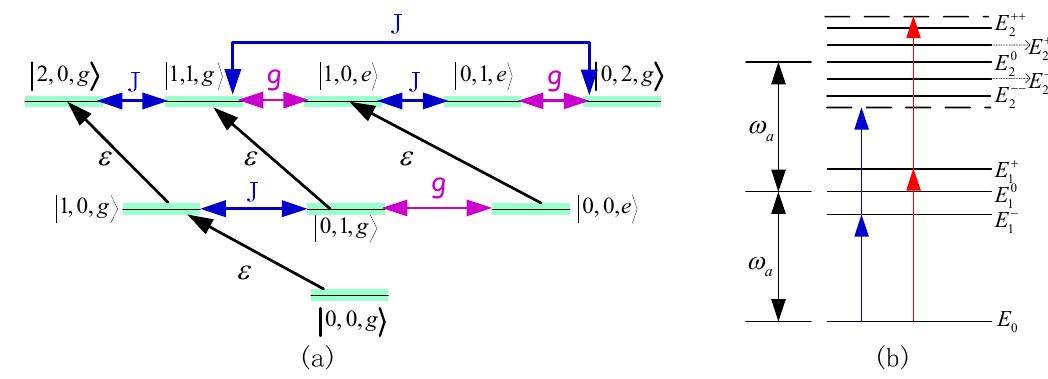
Figure 2. ( a ) Energy levels within two excitation subspaces and the corresponding excitation paths; ( b ) the eigenenergy spectrum of the dressed states within two excitation subspaces.